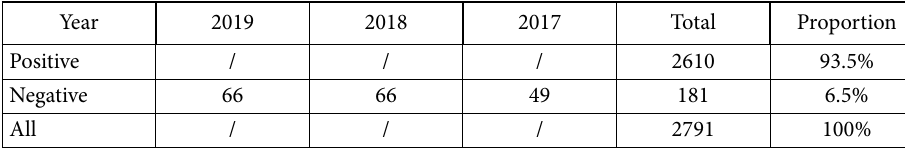
Table 3. Statistical chart of normal